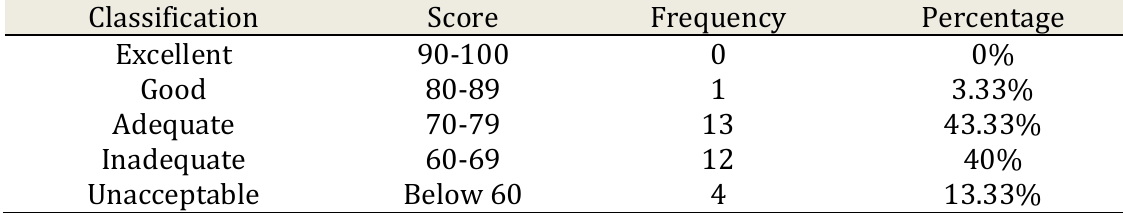
Table 3. The students’ pre -test result in control cla ss